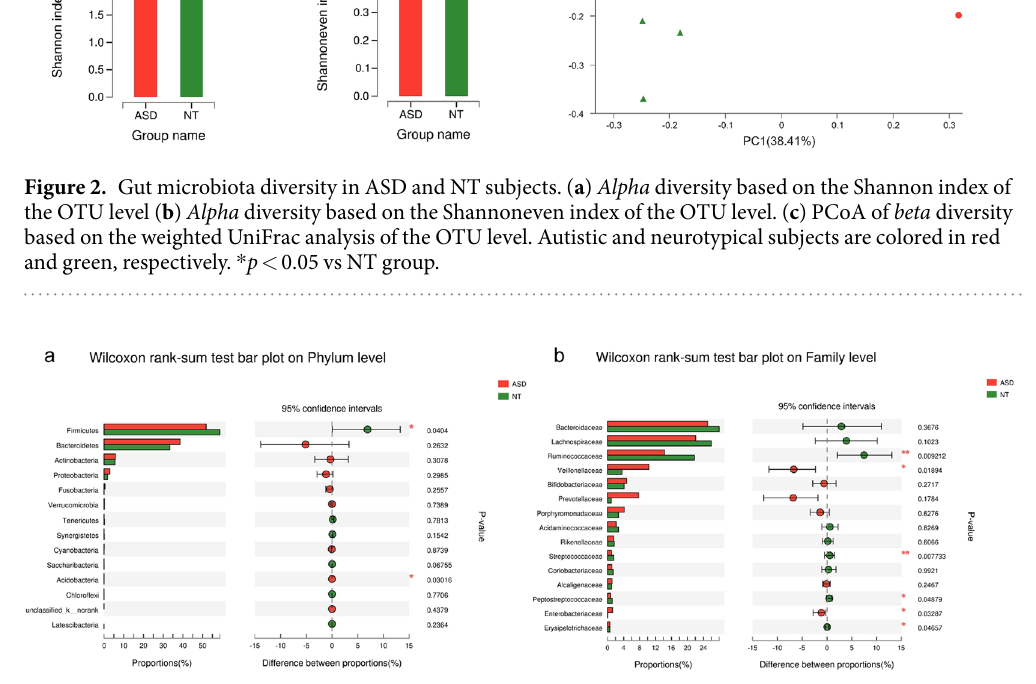
Figure 3. Abundances of taxa in ASD and NT participants. The mean relative abundances of taxa at the phylum ( a ) and family ( b ) levels in ASD and NT participants. Red and green bars indicate the mean relative abundances of taxa in autistic and neurotypical subjects, respectively. * p < 0.05 vs NT group; ** p < 0.01 vs NT